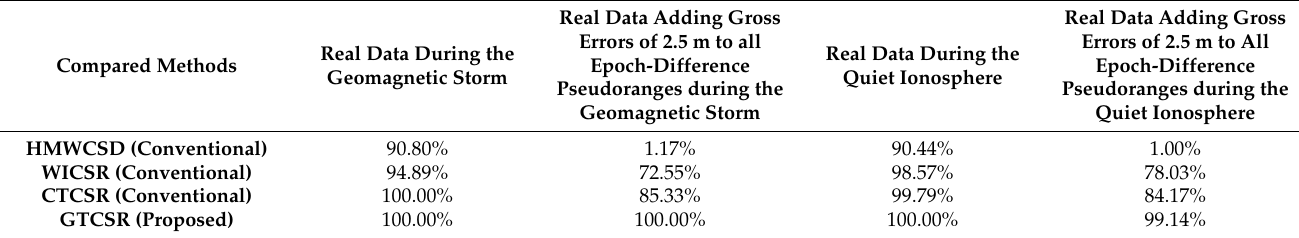
Table 5. The success rates of all observable triple-frequency GPS satellites’ cycle slip processing results.